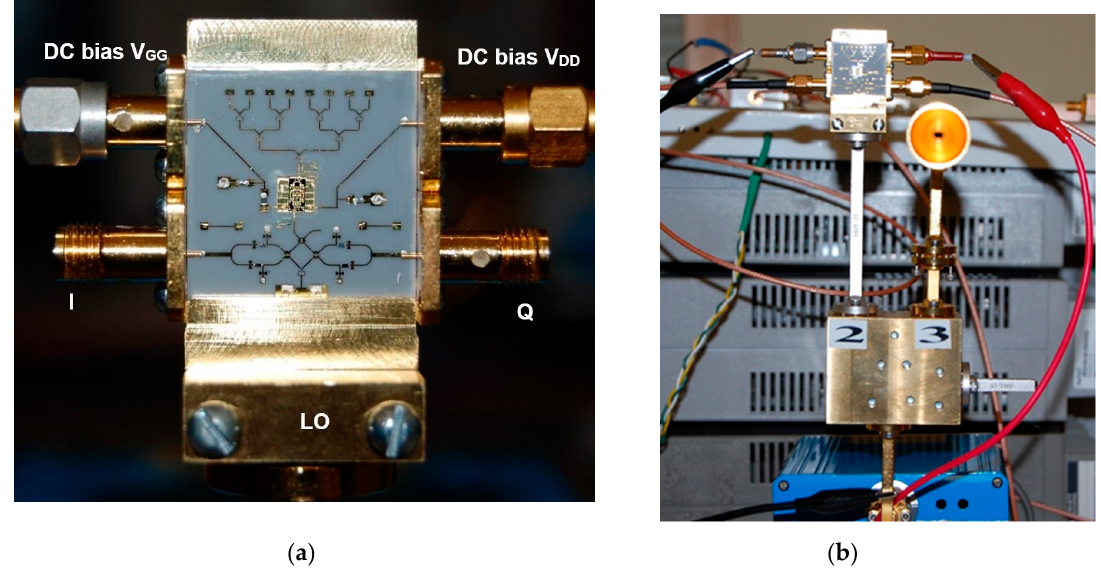
Figure 16. ( a ) E-band multi-port radar sensor receiver in a brass fixture with standard WR-12 flange and SMA connectors; ( b ) complete radar sensor including the waveguide transmitter.